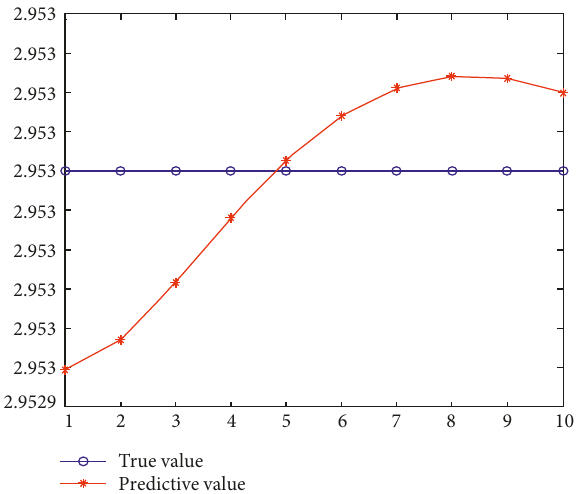
Figure 7: Comparison of RBF-predicted and real